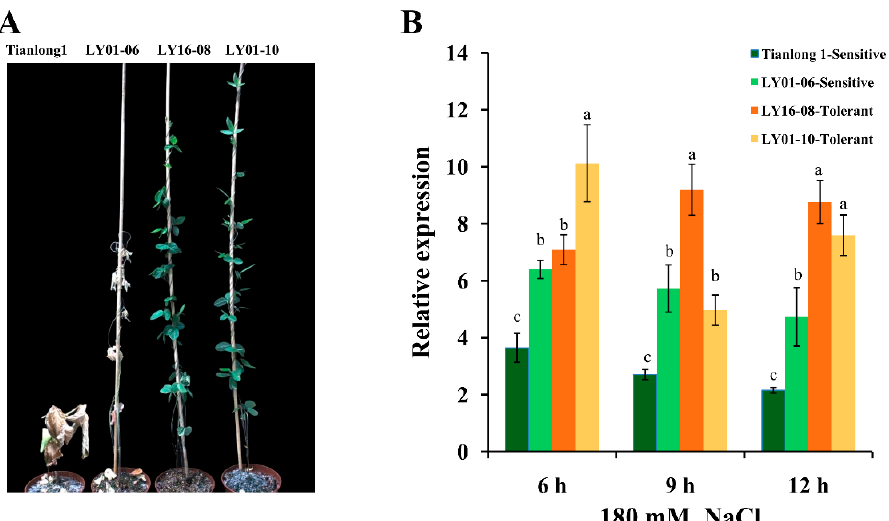
Figure 2. Phenotype and relative expression of GsPRX9 in the roots of four soybean varieties under salt stress. ( A ) Phenotypes of four soybean varieties at seven days after 180 mM NaCl stress. ( B ) Relative expression of GsPRX9 in response to salt stress. Soybean seedlings were treated with 0 or 180 mM NaCl for 6 h, 9 h, and 12 h and the root samples were collected. Roots receiving 0 mM NaCl treatment at each time point were used as controls. Data represent mean and standard deviation of three repeats ( n = 3). Data with the same letters in lowercases (a, b, and c) above bars indicate no significant di ff erences at the 0.05 level between soybean varieties at each time point according to Duncan’s multiple range test.